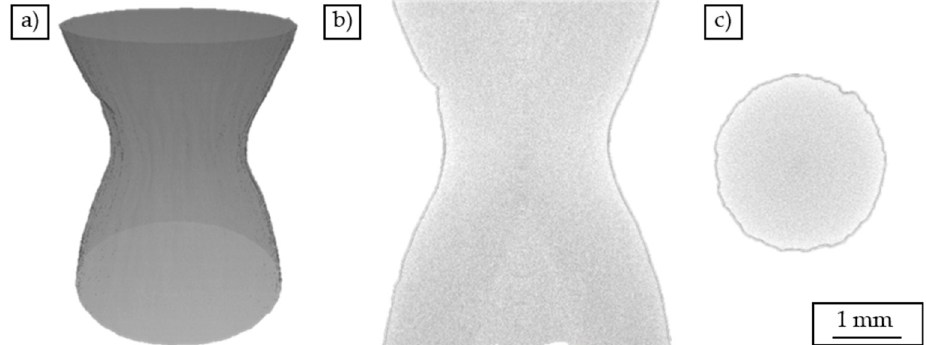
Figure 5. Volume reconstruction of cast-based specimen tested in a tensile test: ( a ) three-dimensional representation, ( b ) cross-sectional view parallel to the load direction, ( c ) cross-sectional view perpendicular to the load direction.